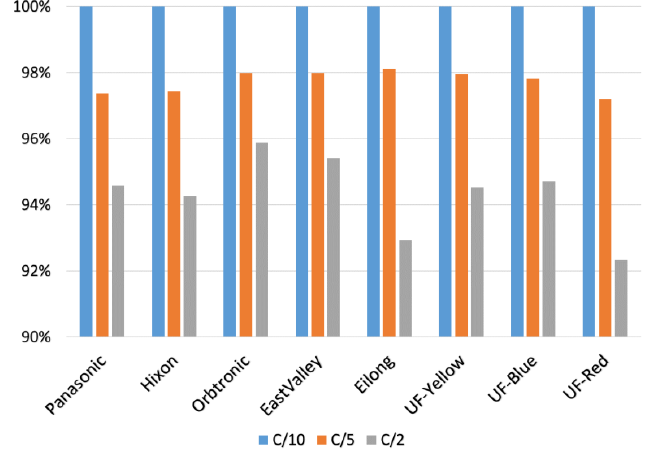
Figure 4. Capacity comparisons for each cell type normalized to C/10 discharge capacity. Data shown are the average of discharges at each rate.